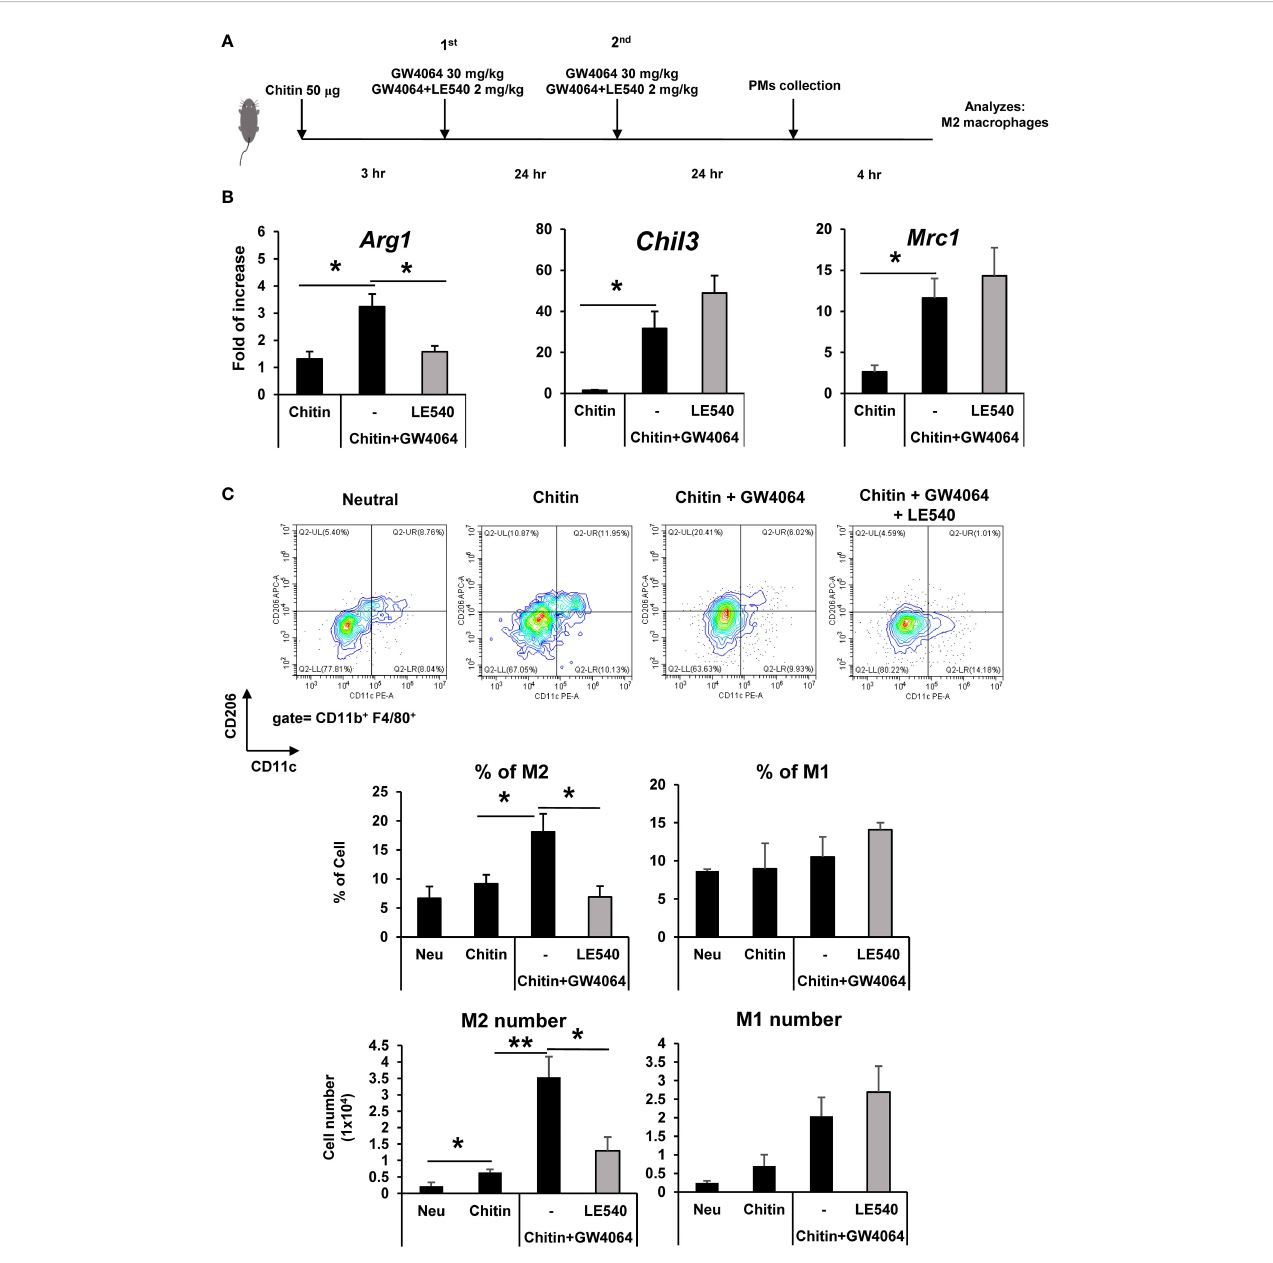
FIGURE 5 Administration of a retinoic acid receptor inhibitor reduced GW4064-enhanced M2 macrophages in chitin-treated mice. (A) The schematic protocol to induce M2 peritoneal macrophages by injection of chitin particles and assess the effects of GW4064 and LE540 on M2 macrophage induction in vivo . The mice received an intraperitoneal injection of 50 µg of chitin to prime M2 induction for 3 hr and then either 30 mg/kg bodyweight of GW4064 or GW4064 together with 2 mg/kg bodyweight of LE540 were administered two times within a 24 hr interval. (B) Peritoneal macrophages were collected for further analysis. Messenger RNA expression of M2-associated genes in collected peritoneal macrophages (PMs) was analyzed by real-time PCR. (C) Flow cytometric analysis of CD206 + (M2) and CD11c + (M1) from CD11b + F4/80 + PMs. The frequency and total numbers of each population are shown in the lower panel. Five mice were used in each experimental group, except for the control group Neu in which four mice were used. Each experiment was repeated two times independently (n=4-5 mice/group), and the result of the representative data shown as mean +/- SE. Analysis of variance (ANOVA) was used for the statistical analysis. * P < 0.05, ** P <